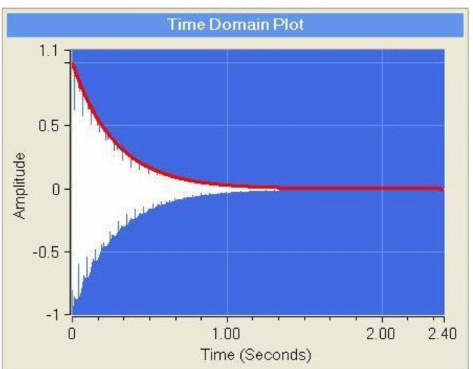
Figure 11. Curve fitted decaying sinusoidal signal. The white zone is the (compressed) recorded sinusoidal signal; the red envelope line is the curve fitted damped exponential function of the signal. The example shows a signal with resonance frequency = 241.2 Hz and a damping ratio value of 0.00237.